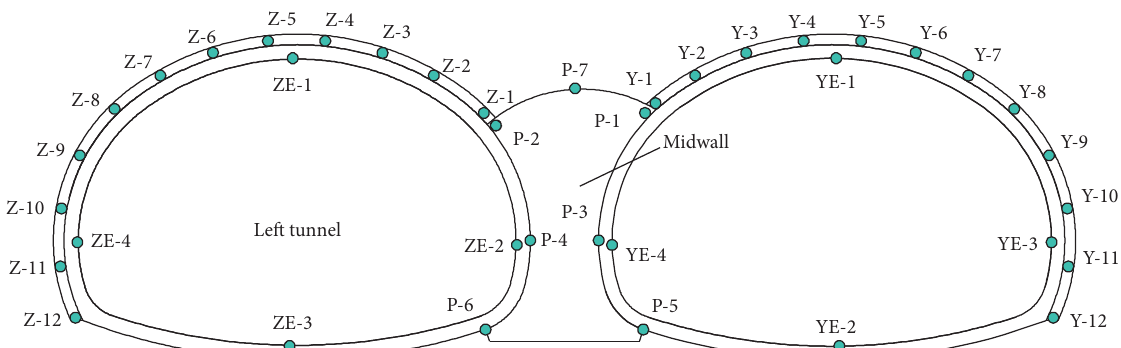
Figure 13: Arrangement of measuring points in the three-dimensional model.